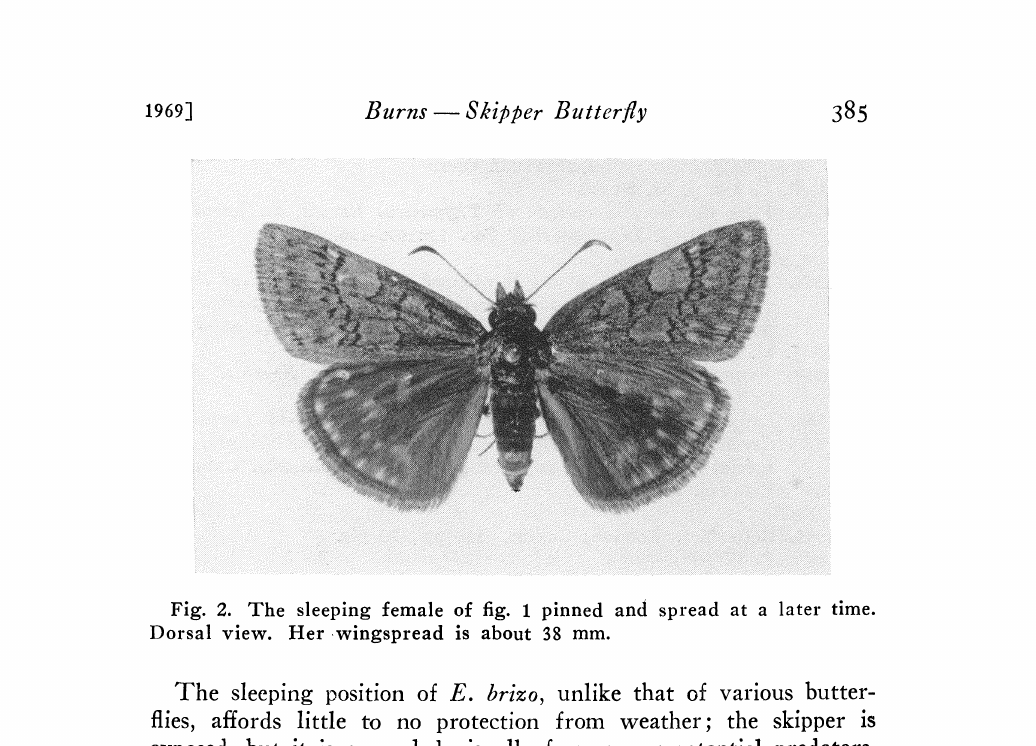
Fig. 2. The sleeping female of fig. pinned and spread at a later time. Dorsal view. Her wingspread is about 38